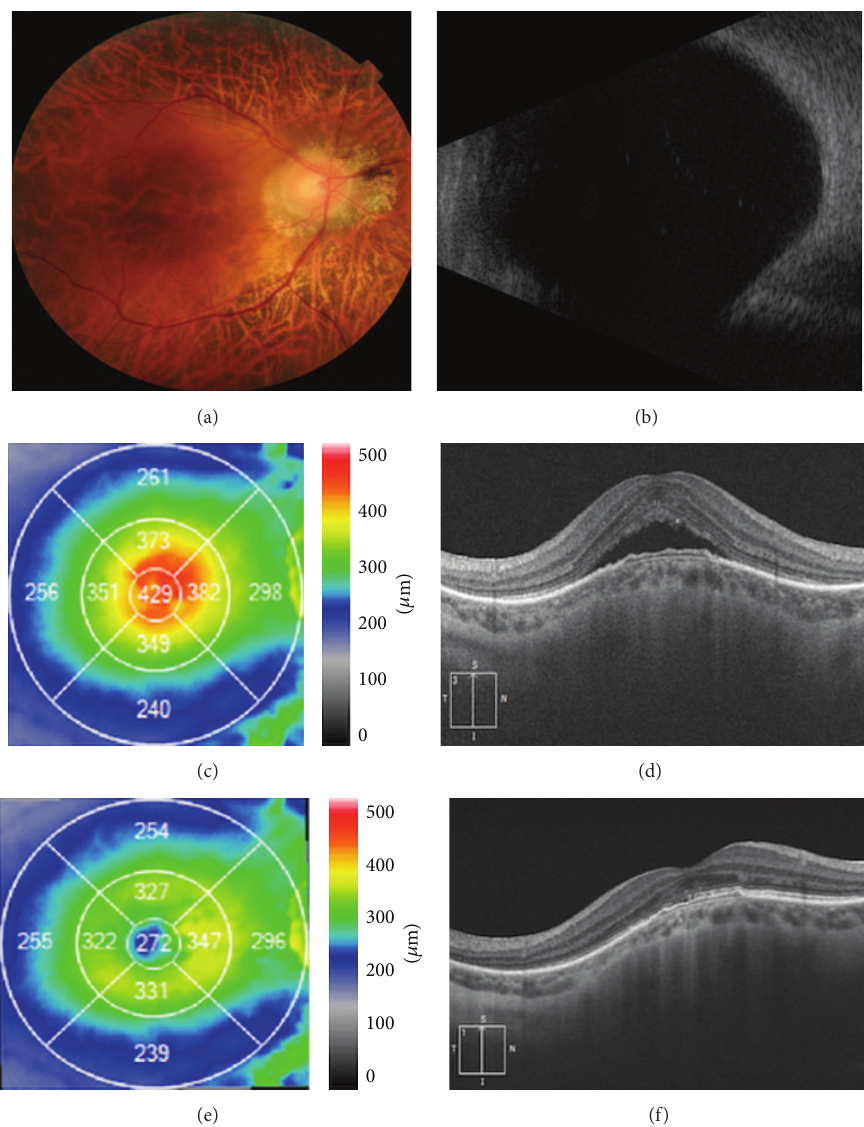
Figure 1: Dome-shaped macula with serous retinal detachment before and after treatment with spironolactone. (a) Color photo showing peripapillary atrophy, marked retinal thinning with visible choroidal vessel, but no hemorrhage in the foveal area. (b) B-scan ultrasound showing an abnormal ocular wall in the posterior fundus. (c) Pretreatment OCT macular map showing increased CRT. (d) Pretreatment OCT image showing serous retinal detachment in the foveal area with no other alterations. (e) Posttreatment OCT macular map showing improvedCRT.(f)PosttreatmentOCTimageshowingresolutionoftheserousretinaldetachmentinthefovealareawithanabnormalellipsoid